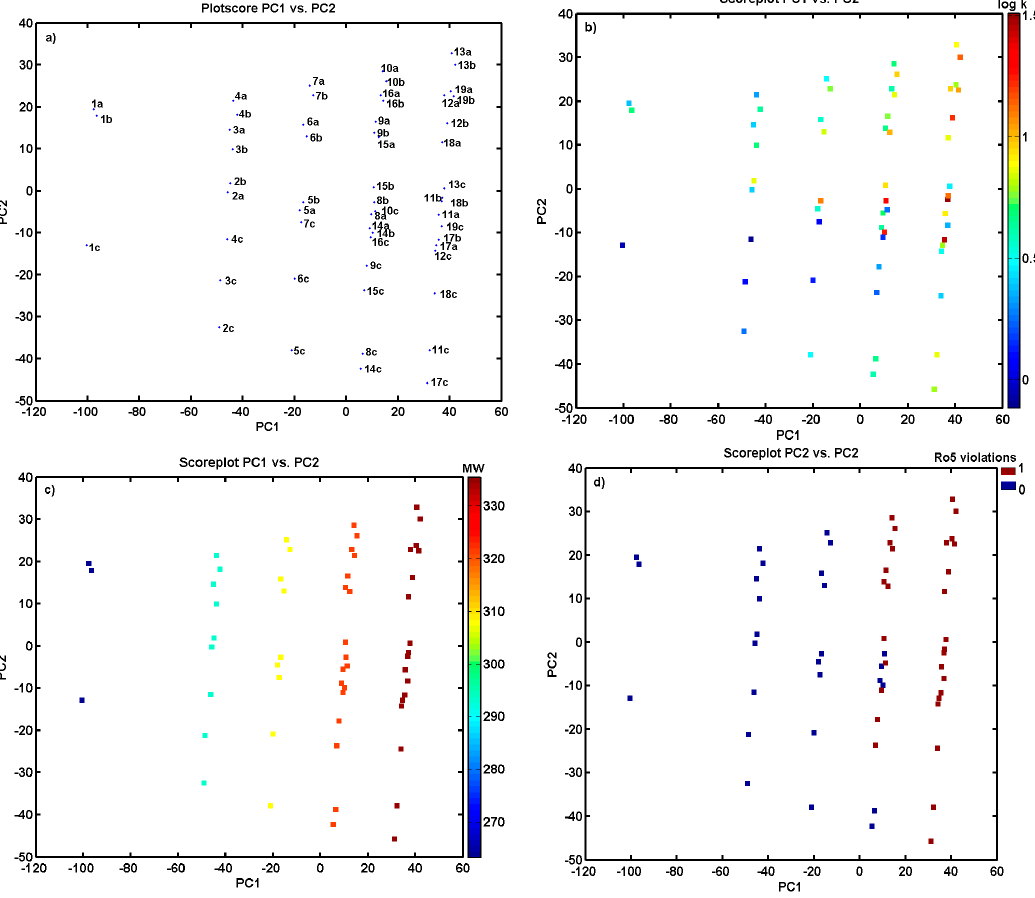
Figure 3. Projection of derivatives 1a – 19c on plane defined by first versus second principal component ( a ) with: log k ( b ), molecule´s weight, ( c ) and number of Lipinski’s Ro5 violations ( d ). Colors code the values of experimental lipophilicity, molecular weight, and the number of Ro5 violations.